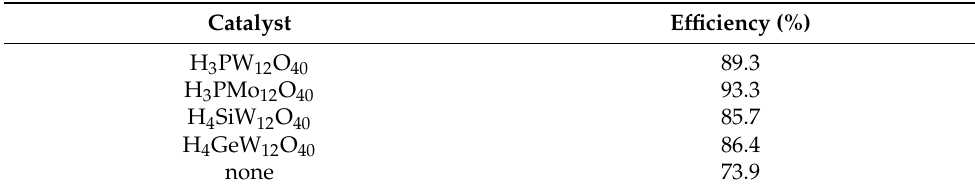
Table 2. Catalytic effects of HPAs on the oxidation of DBT.